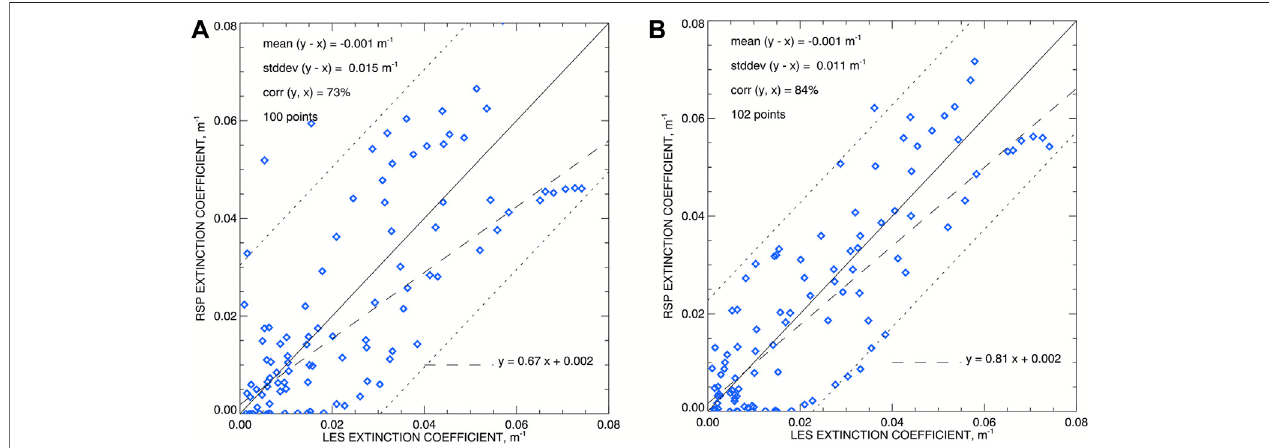
FIGURE11| Quantitativecomparison oftheretrieved extinctioncoef fi cientwiththeinitialdatafromtheLESmodel. Theretrieved k ext fi eldisinterpolatedtotheLES data points. Only the data with above-zero values from both datasets are taken into comparison. (A) The original scatter plot of k ext from both datasets. (B) Same as (A) butwiththeretrieved fi eldshiftedtotheright(awayfromthebrightercloudside)by50 m(asin Figure10A ,right).Ineachplotdashed linerepresentsrobustlinear fi tand two dotted lines bound 2 σ k -corridor around 1 – 1 solid line.